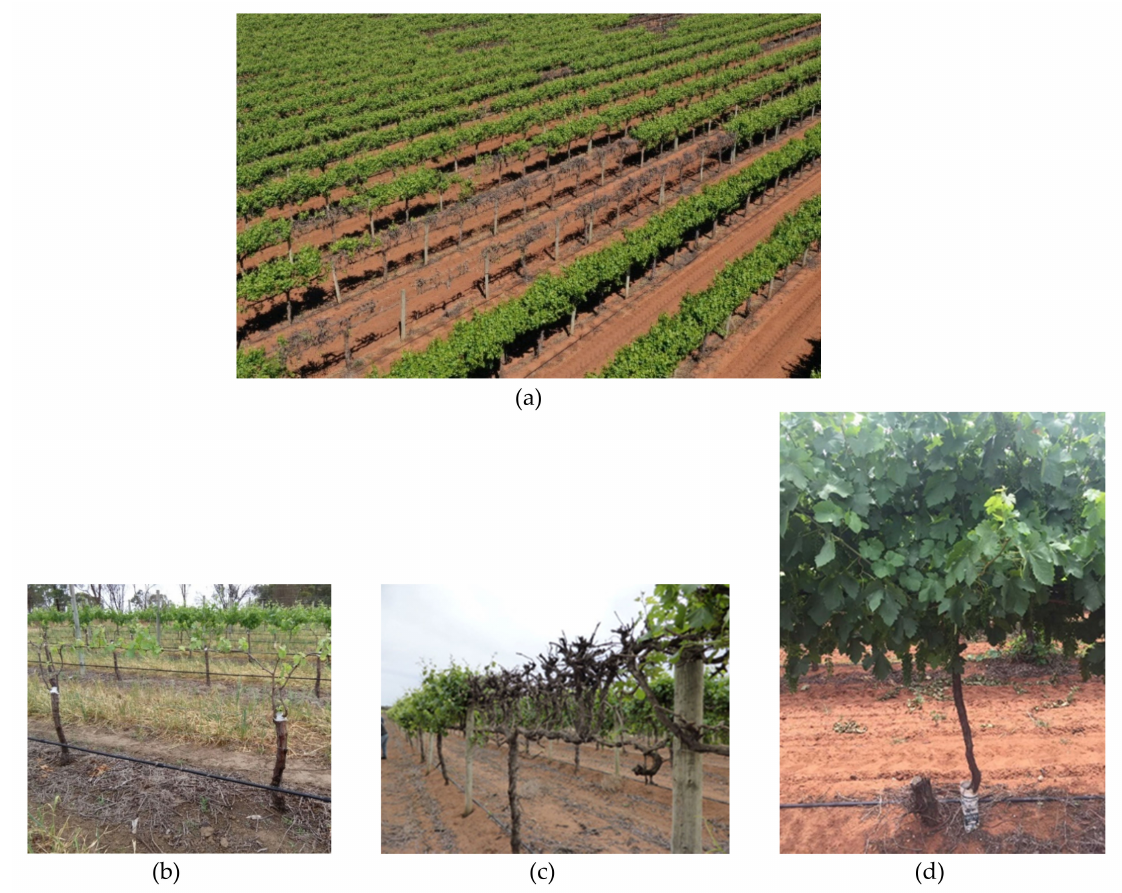
Figure 5. SD-infected grapevines in Australian vineyards. ( a ) Aerial view of a Riverland (South Australia) Shiraz vineyard showing prevalence of Shiraz disease: declining or dead vines with few or no leaves associated with GVA compared to symptomless GVA-infected Chardonnay (two rows on the right); ( b ) Malbec grapevines in a Langhorne Creek (South Australia) vineyard showing typical SD symptoms of restricted spring shoot growth; ( c ) same Shiraz block showing dieback associated with both SD and fungal trunk diseases; ( d ) Shiraz grapevine planted next to a stump, which tested positive for GVA two years